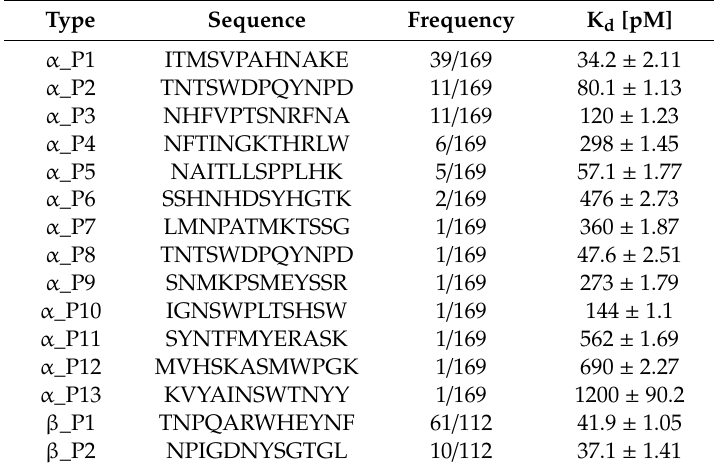
Table 1. P. capsici α , β -tubulin binding peptide sequences and phage binding affinities.